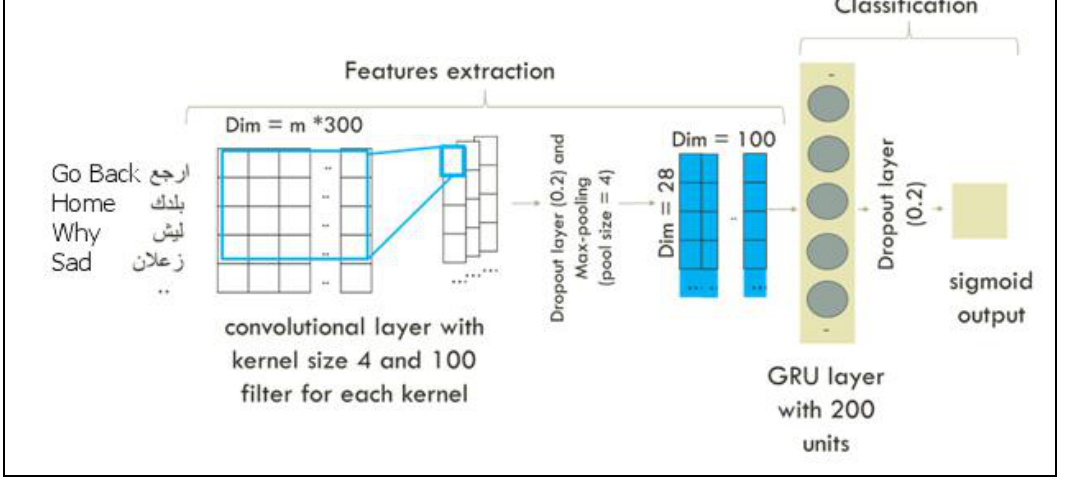
Figure 3. CNN + GRU architecture .